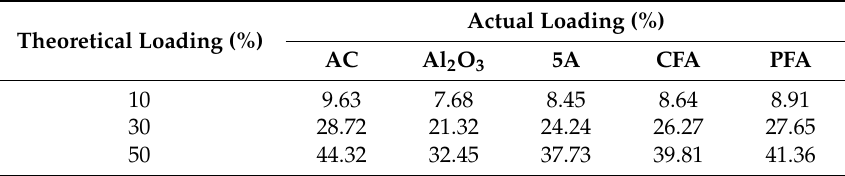
Table 2. Actual loading of different supports by